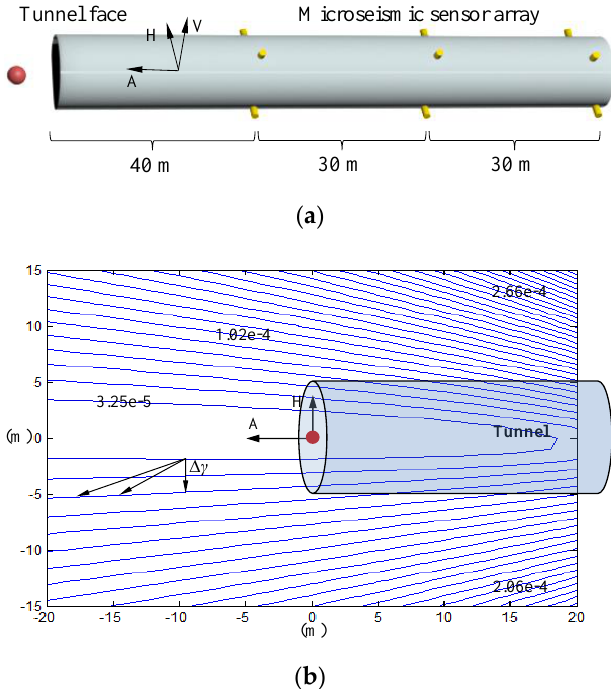
Figure 2. Microseismic sensor array and residual space: ( a ) layout of the microseismic array; ( b ) residual space in the A-H plane, and the location error in the axial direction is the greatest.